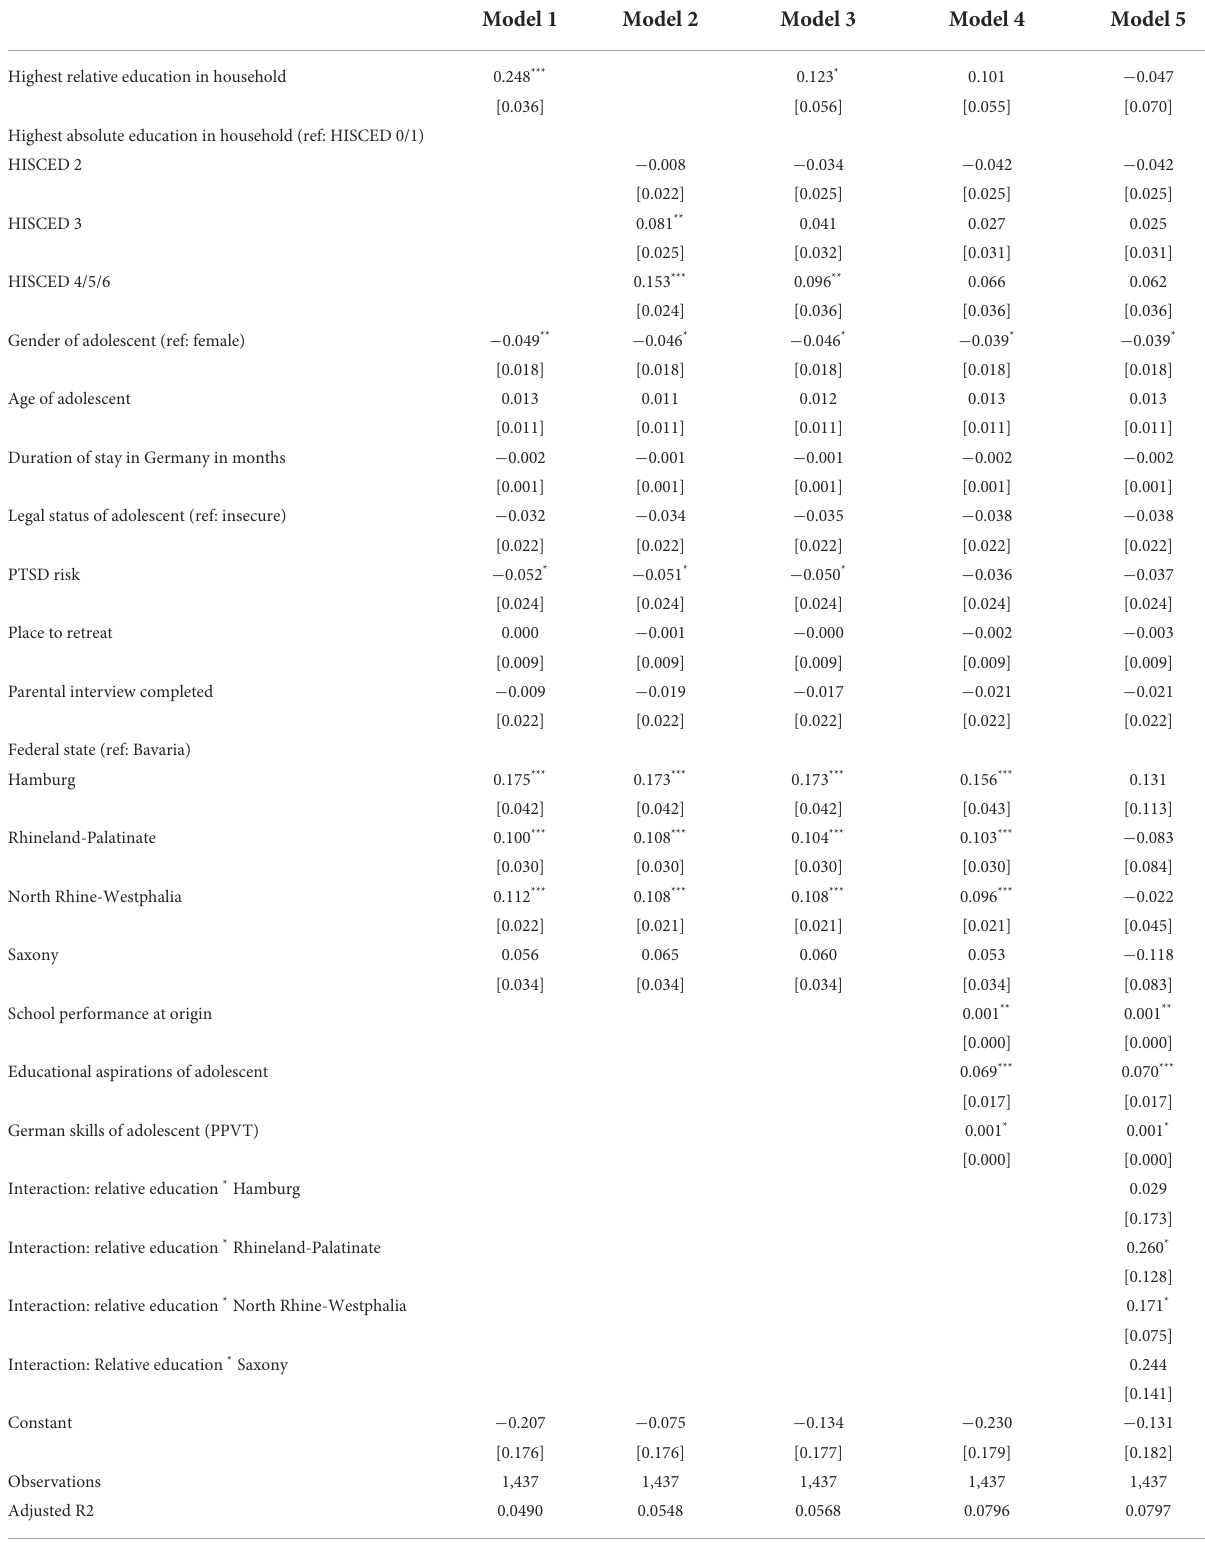
TABLE 2 Linear probability models of adolescents’ higher-level secondary school